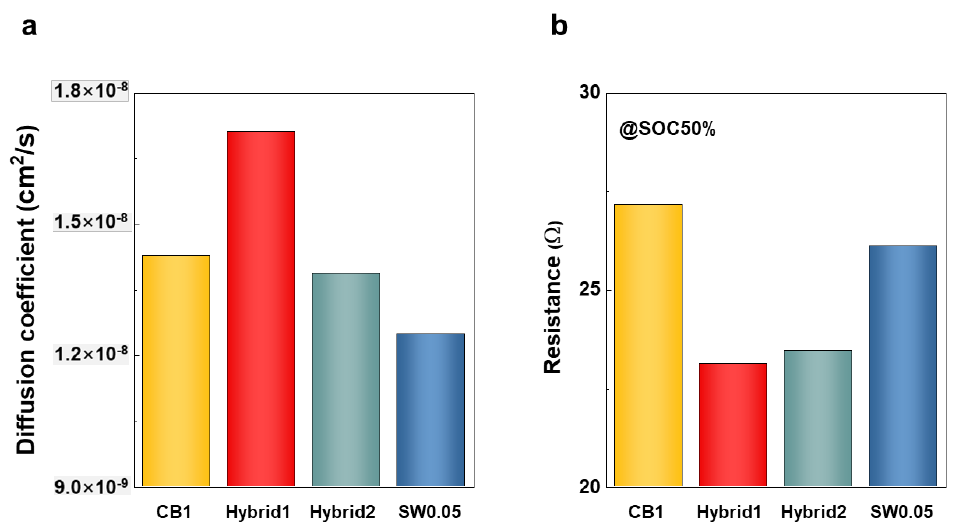
Figure 5. Characterization of electrochemical properties of cycled full cells: ( a ) Li-ion diffusion coefficient calculated using GITT at 0.5 C; ( b ) DCIR-based resistance at SOC50%.